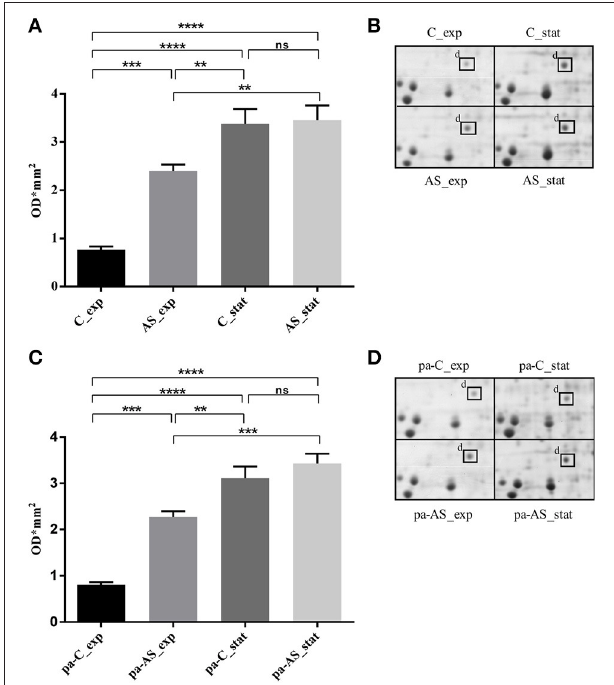
FIGURE 4 | Expression of L. innocua ATCC 33090 USP under physiological or acid stress condition represented as spot area revealed in non-pre-acid-adapted cells (A) or in pre-acid-adapted cells (C) and as high magnification of 2-DE gels of the proteome from non-pre-acid-adapted cells (B) or in pre-acid-adapted cells (D) . Spots area values are the average of three replicate experiments and the error bars represent the standard deviation. The *indicates that the difference is statistically significant as determined by one-way ANOVA followed by the Tuckey’s multiple comparison test (** p < 0.05), (*** p = 0.0001), (**** p < 0.0001) while ( ns ) indicates that no statistical differences were